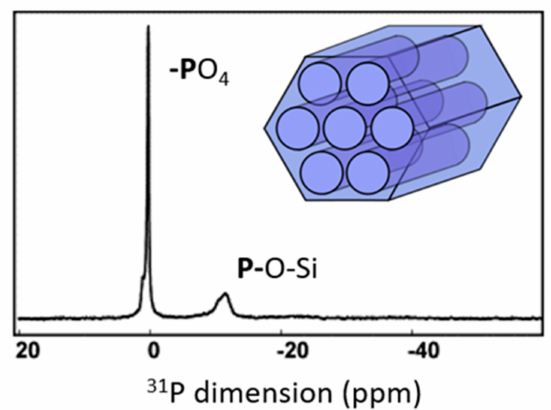
Figure 13. 31 P MAS-NMR spectrum of MCM-41 phosphate